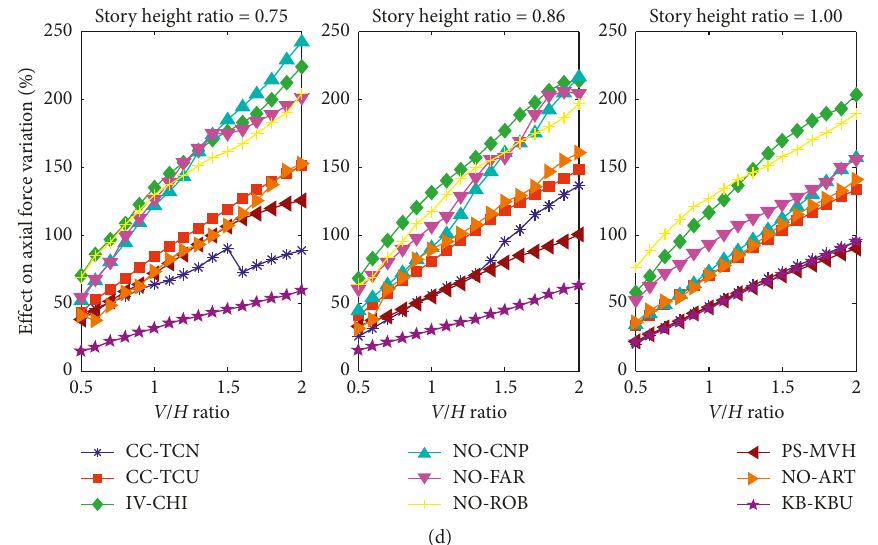
Figure 7: Effect on axial force variation: (a) span length, (b) span length, V / H ratio, (c) span ratio, and (d) storey height ratio.